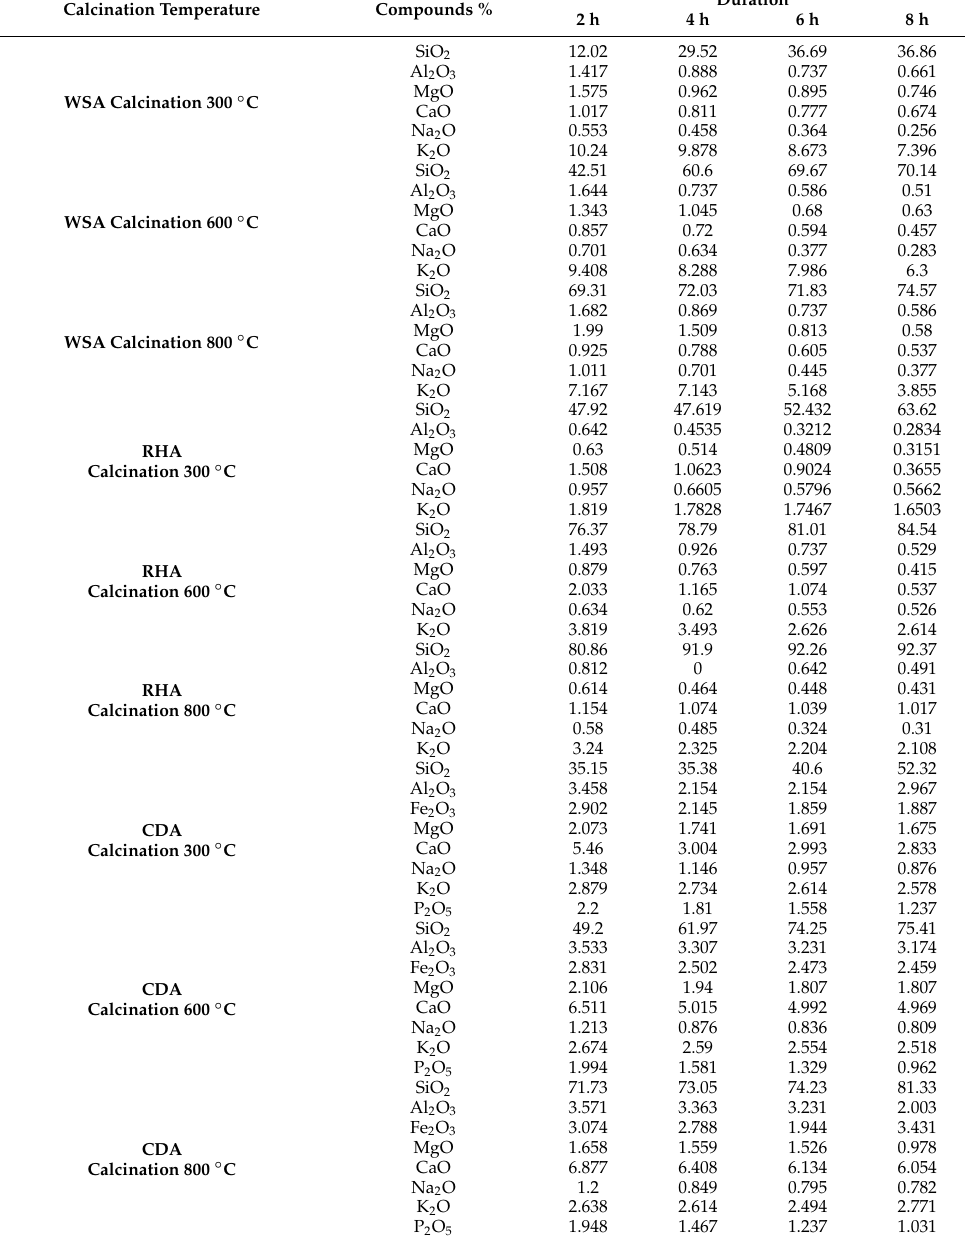
Table 1. Chemical compositions of calcined